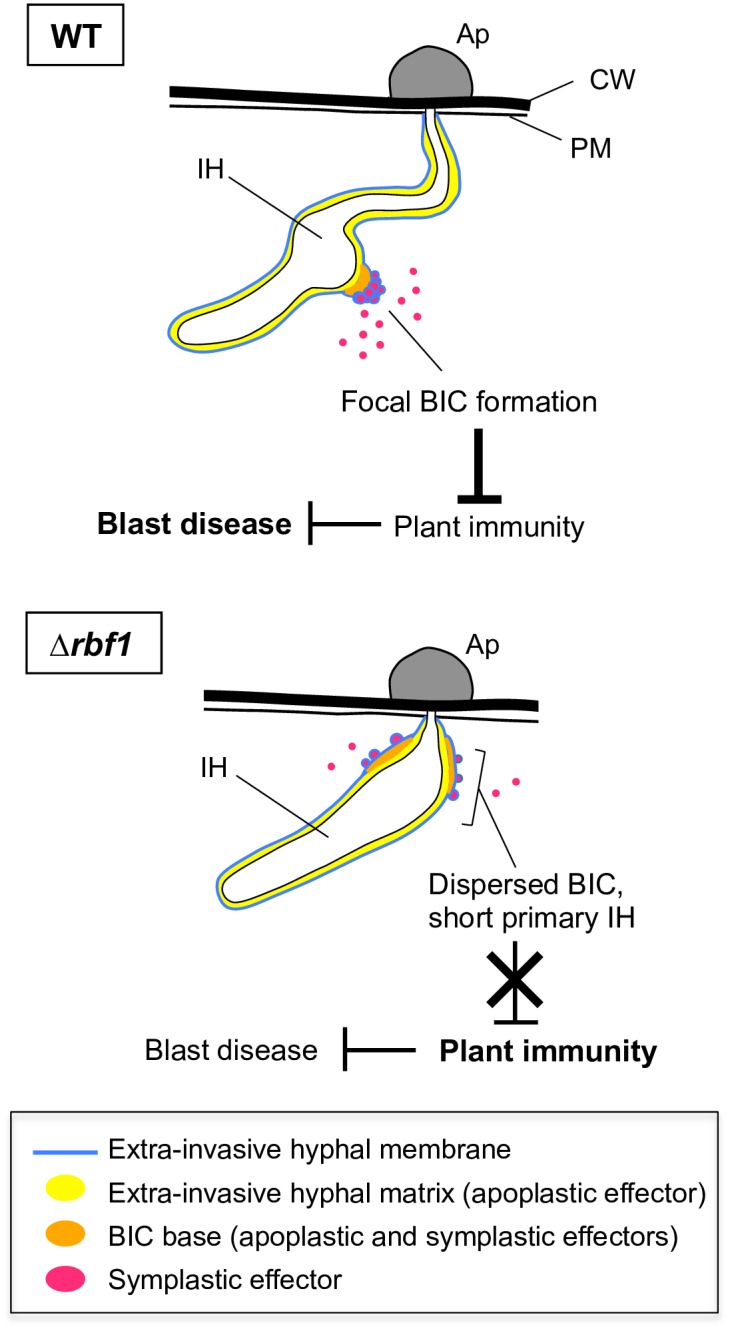
Summary of phenotypes shown in the wild-type Magnaporthe oryzae and the RBF1-disrupted mutant.The biotrophic interfacial complex (BIC) is a specialized region of the EIHMx focally formed at the tip of the tubular invasive hypha that differentiates into the bulbous pseudohyphae. The BIC comprises the aggregated EIHM in which symplastic effectors detected as a cluster of puncta and the BIC base in which apoplastic effectors also preferentially accumulate. From the characterization of the knockout mutants (Δrbf1), it is deduced that Rbf1 plays a crucial role in the development of the focal BIC structure and the hyphal differentiation, which is required to lower the activation of host immune response, thus allowing the establishment of the biotrophic invasion. Ap, appressorium; CW, host cell wall; IH, invasive hyphae; PM, host plasma membrane.